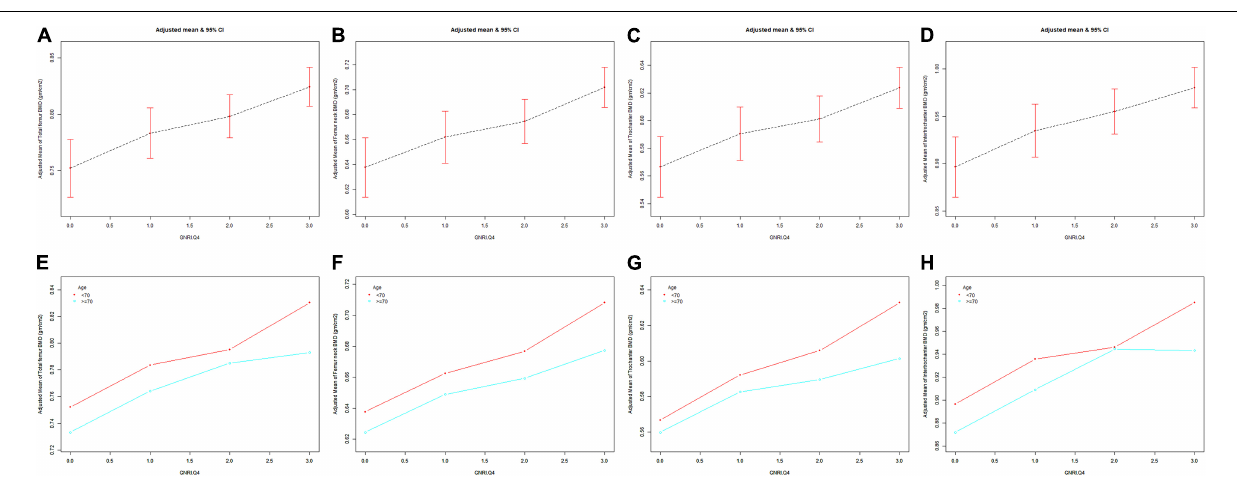
FIGURE 3 | The association between GNRI.Q4 and femur BMD. Age [in panels (A–D) ], race/ethnicity, BMI, educational level, marital status, PIR, smoked at least 100 cigarettes, hypertension status, diabetes status, ever used prednisone or cortisone daily, ever used female hormones, had a hysterectomy, moderate or vigorous activity, and postmenopausal period were adjusted. (A,E) Total femur BMD; (B,F) Femur neck BMD; (C,G) Trochanter BMD; (D,H) Intertrochanter BMD. BMD, bone mineral density; GNRI.Q4, geriatric nutritional risk index quartiles; PIR, poverty income ratio; BMI, body mass